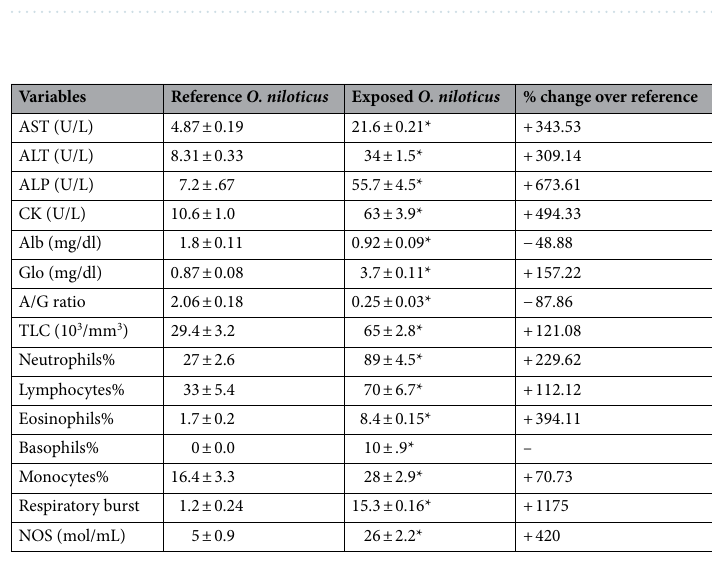
Table 2. MPI values in both group of fishes.